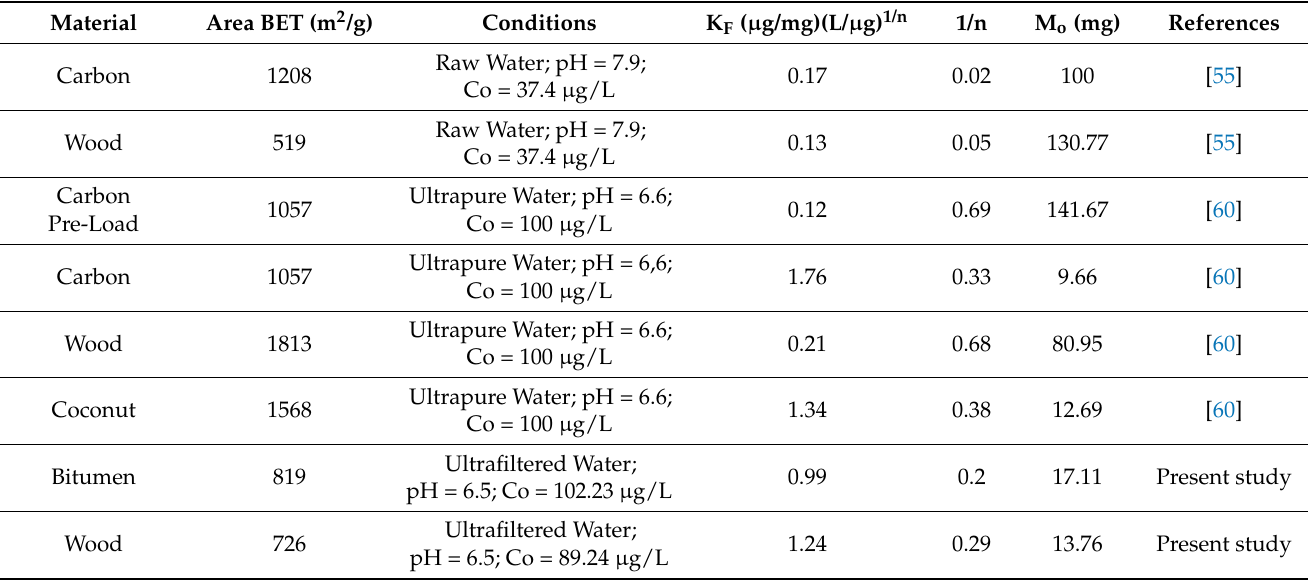
Table 5. Freundlich parameters for CYN removal in activated carbon—Bibliographic references.